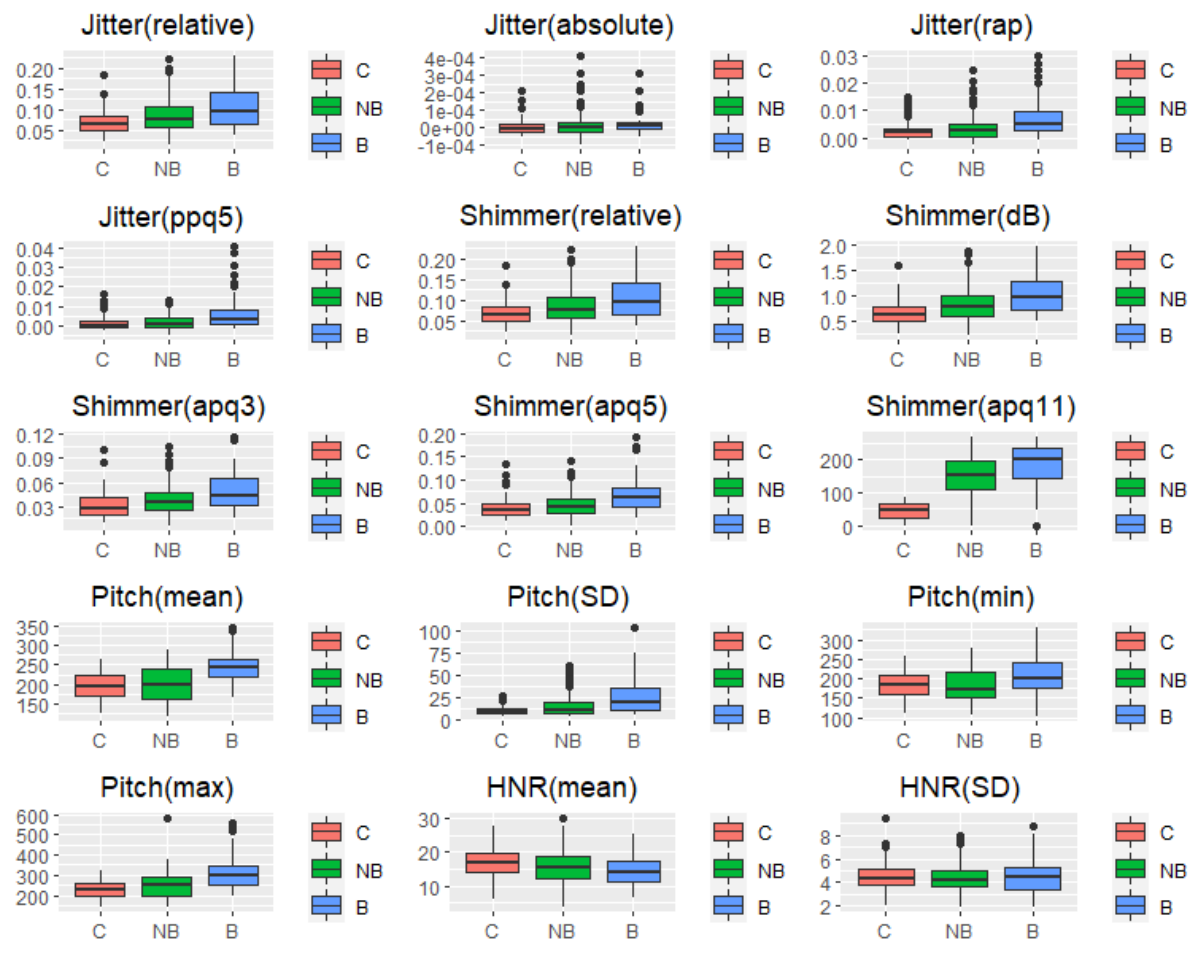
Figure 1. Box plots of features by group. B: patients with amyotrophic lateral sclerosis (ALS) with bulbar involvement; C: control group; HNR: harmonics-to-noise ratio; NB: patients with ALS without bulbar